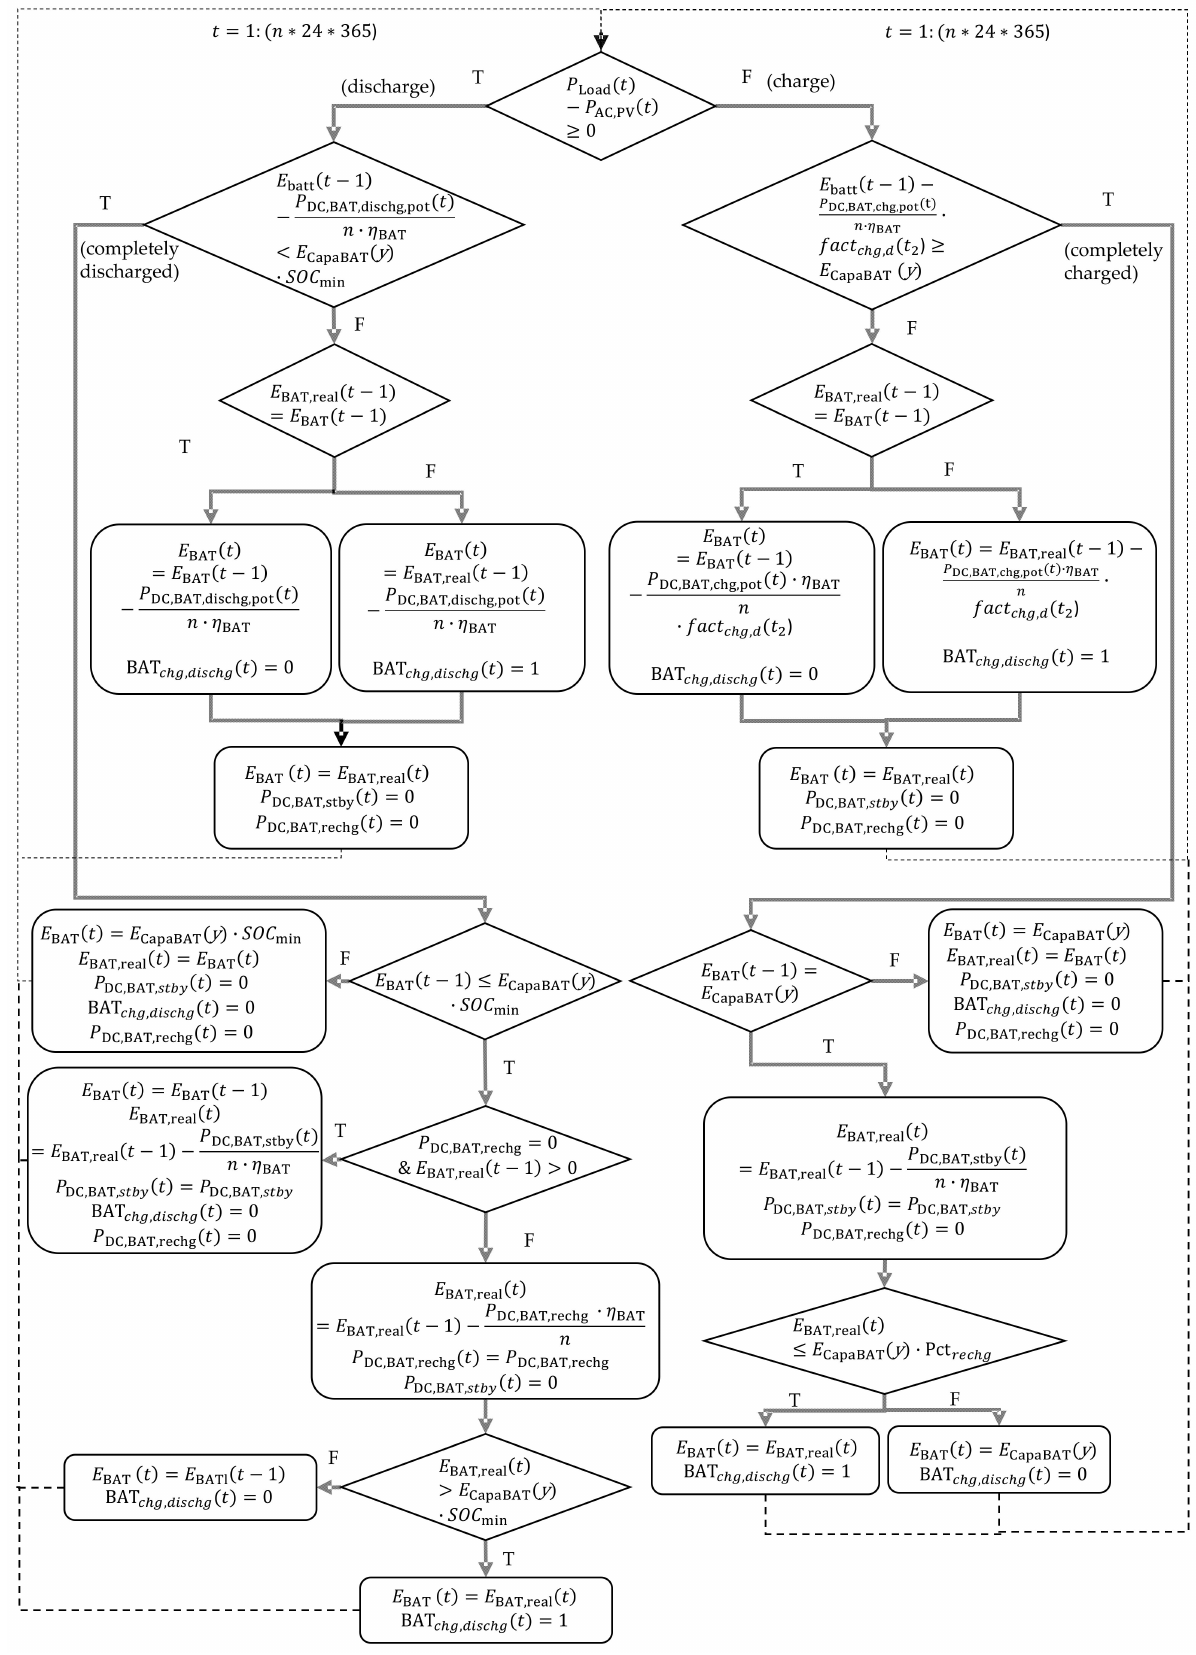
Figure 5. Calculation of the energy stored in the battery and the DC standby consumption—T stands for true and F for